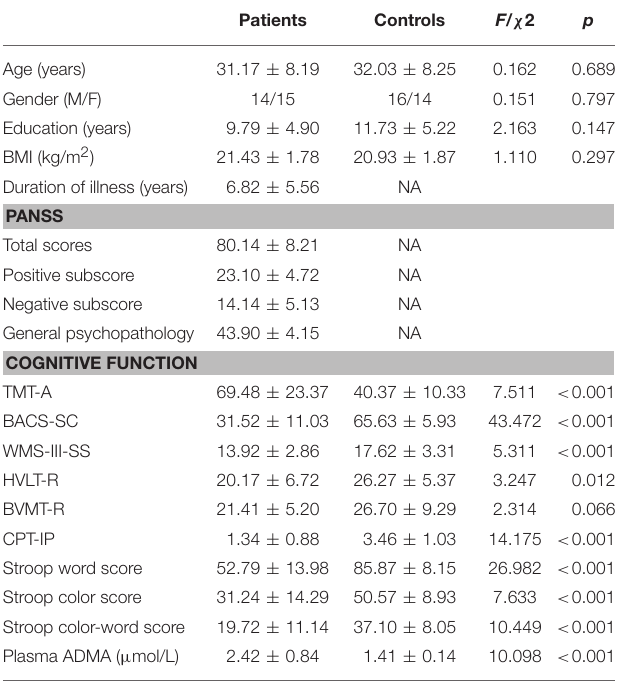
TABLE 1 | Baseline demographic and clinical characteristics for patient and control